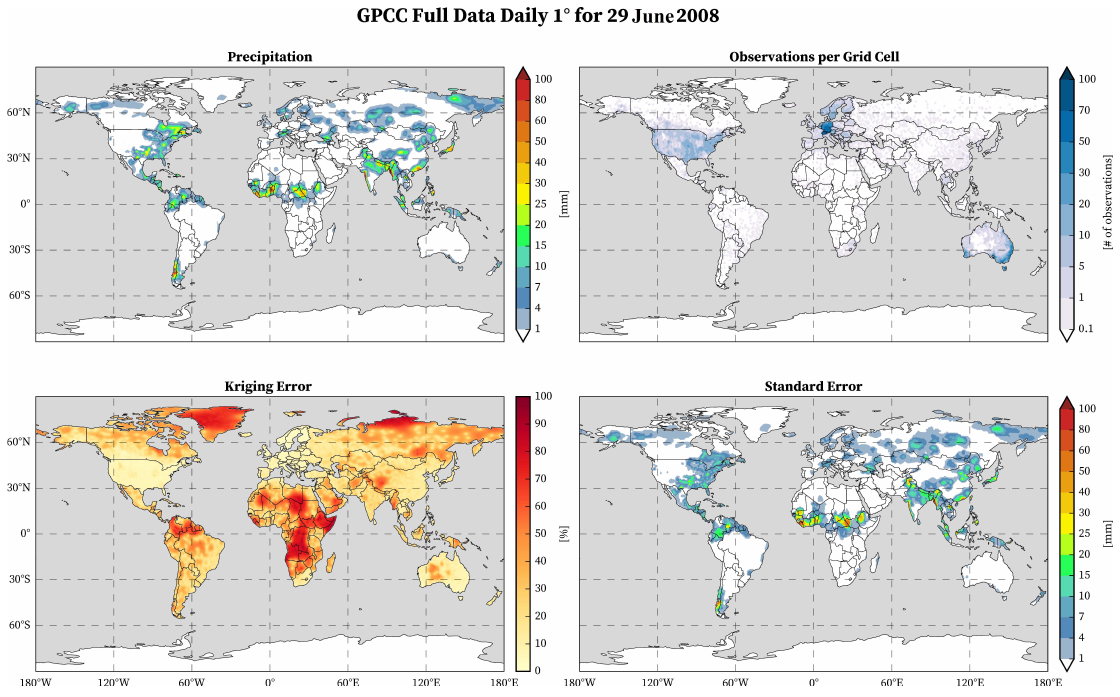
Figure 2. Example of the features of the Global Precipitation Climatology Centre (GPCC) daily precipitation product for 29 June, 2008. (adapted from [13]). Top left: estimated amount of precipitation in mm · d − 1 . Top right: distribution of precipitation measurement stations. Bottom left: kriging error in %. Bottom right: standard deviation according to the method of [19] in mm · d − 1